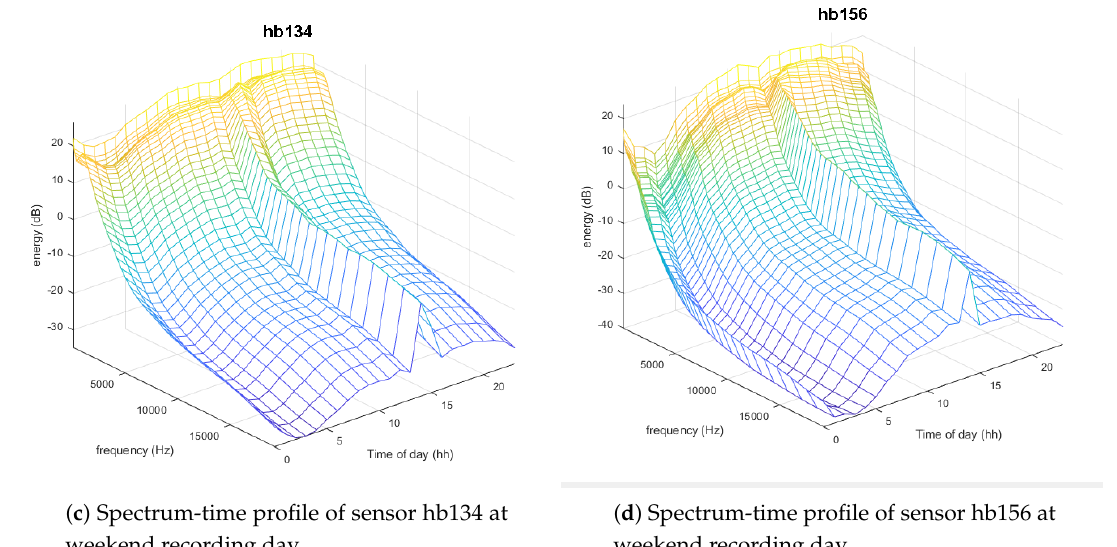
Figure 5. Spectrum-time profiles of sensors hb134 and hb156 at weekday (the 2nd of November 2017) and at weekend day (the 5th of November